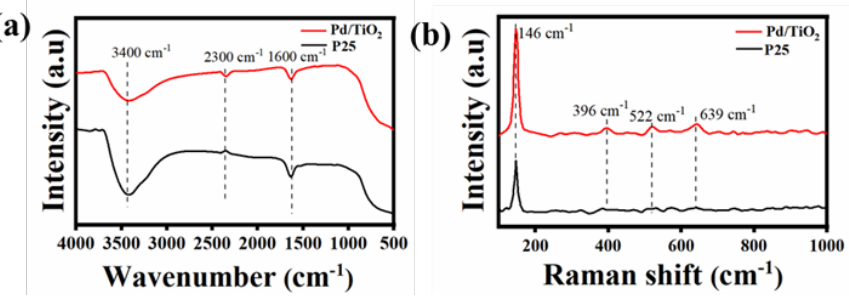
Figure 2. FT-IR spectra ( a ) and Raman spectra ( b ) of TiO 2 and Pd/TiO 2 .